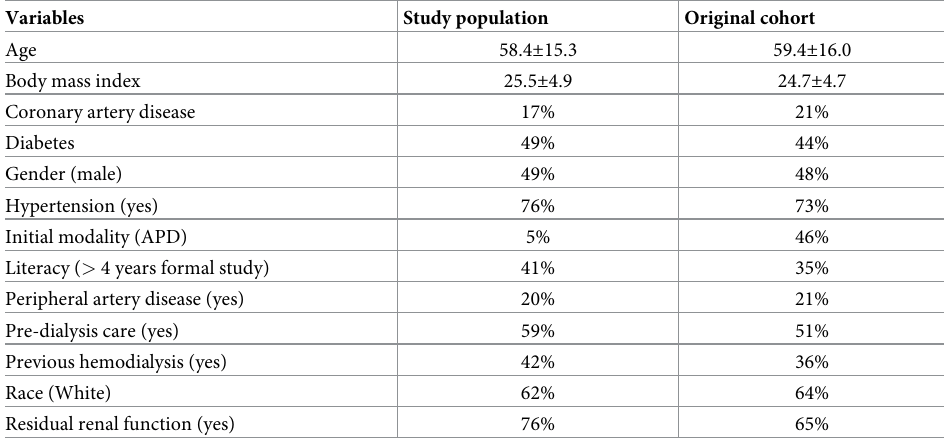
Table 1. Clinical and demographic